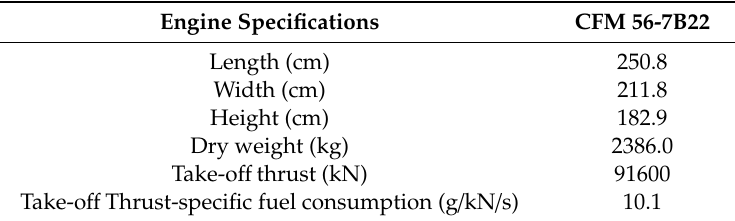
Table 4. Safran CFM 56-7B22 engine specifications